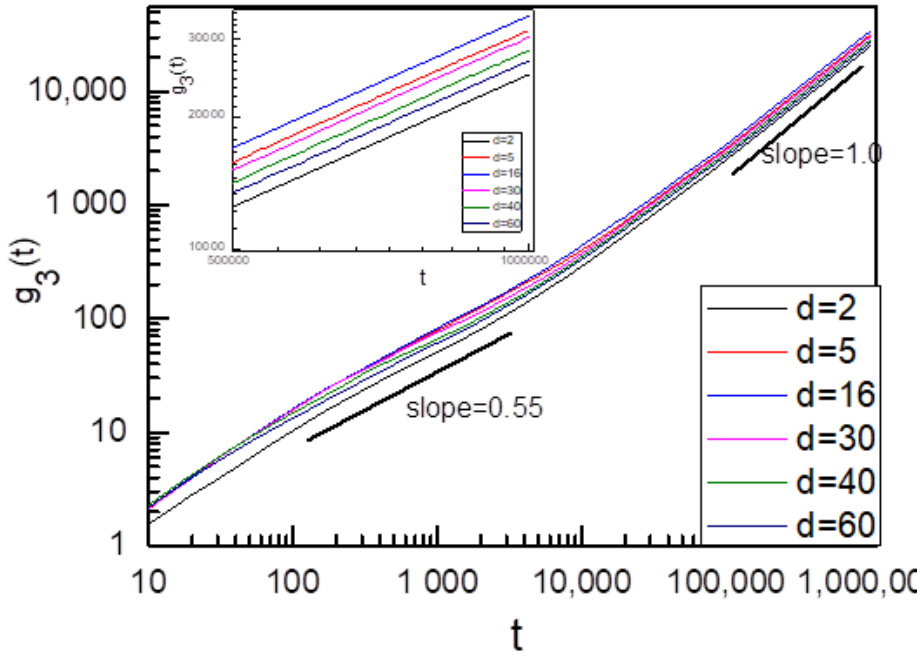
Figure 2. Time dependence of g 3 (t) of ring chain on the symmetric fixed rod-like chains (K 1 = K 2 = ∞ ) with different distances d between two symmetric fixed rod-like chains.